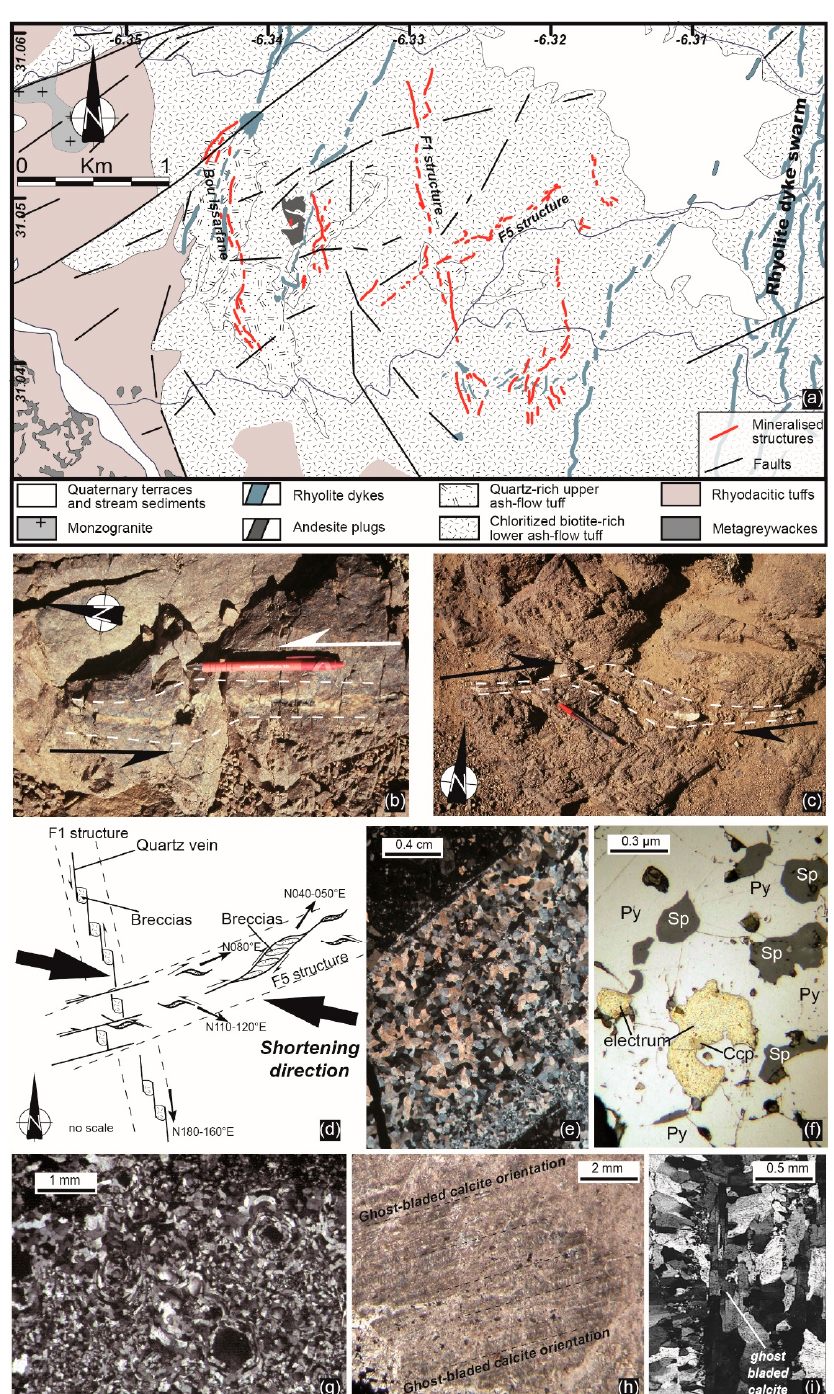
Figure 10. Main features of the Zone des Dykes deposits [47]. ( a ) General map of the Zone des Dykes Au-Ag deposit at the crossing between the F1 and F5 vein systems and Bou Issarfane area (after Tuduri [47]). ( b ) Pull-apart texture indicative of a left-lateral shearing movement along the F1